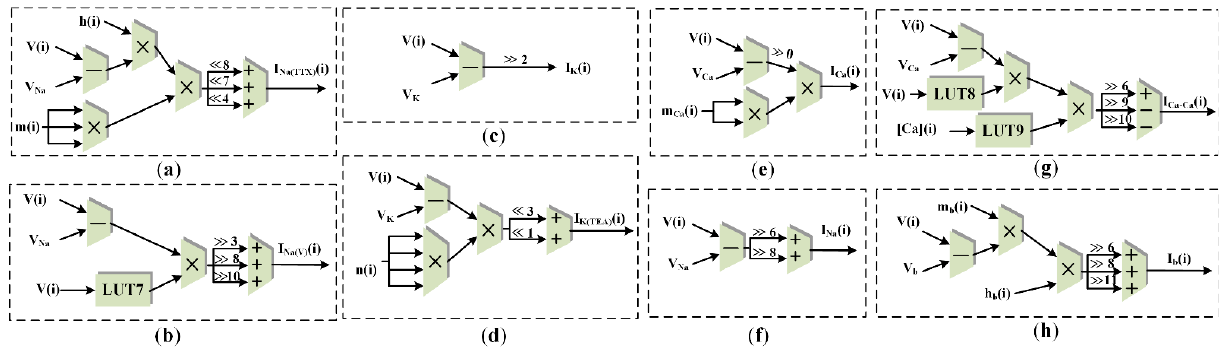
Figure 8. Neuron model variable pipeline calculation structure, containing ( a ) the membrane potential (V) pipeline and ( b – h ) seven variable pipelines (h, m, n, h b, m b, m Ca, and [Ca 2+ ]), respectively updating the eight variables in the K-K neuron model. I syn and I syn_sn are the chemical synaptic current and the external random synaptic current injected into the neuron, respectively.